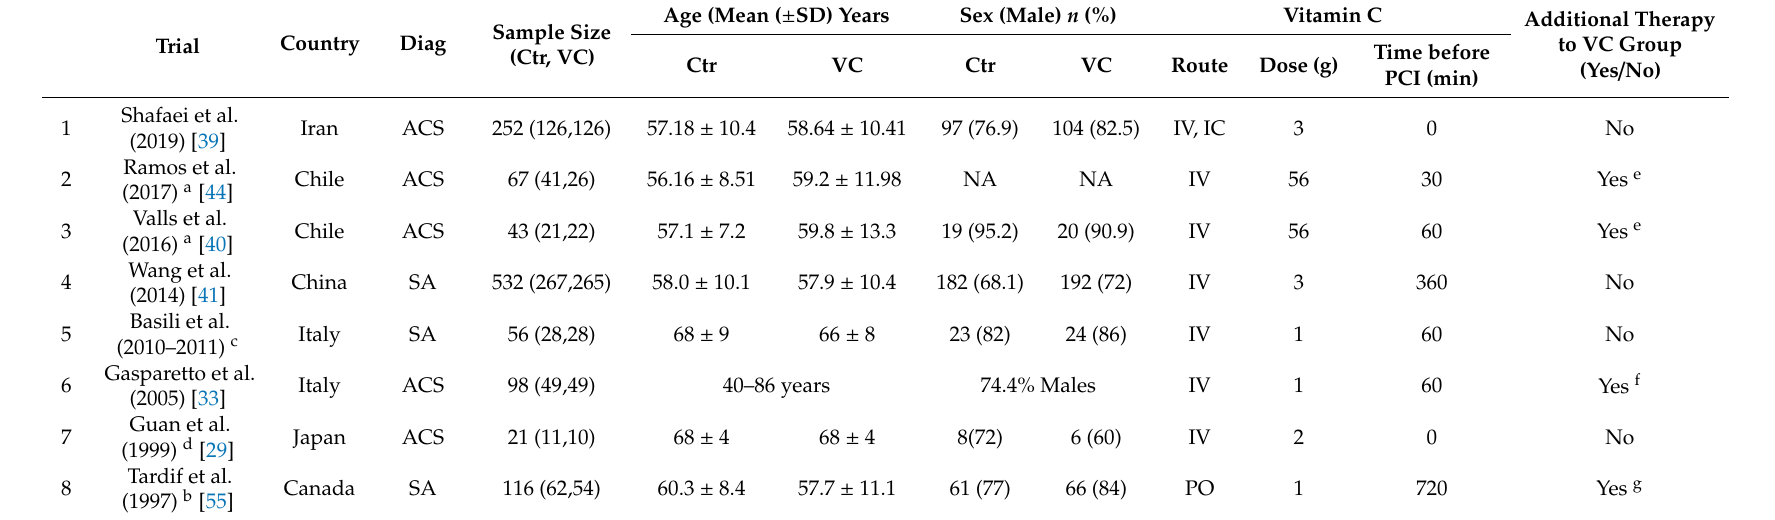
Table 1. Demographics of 10 Randomized Clinical Trials Meeting the Inclusion and Exclusion